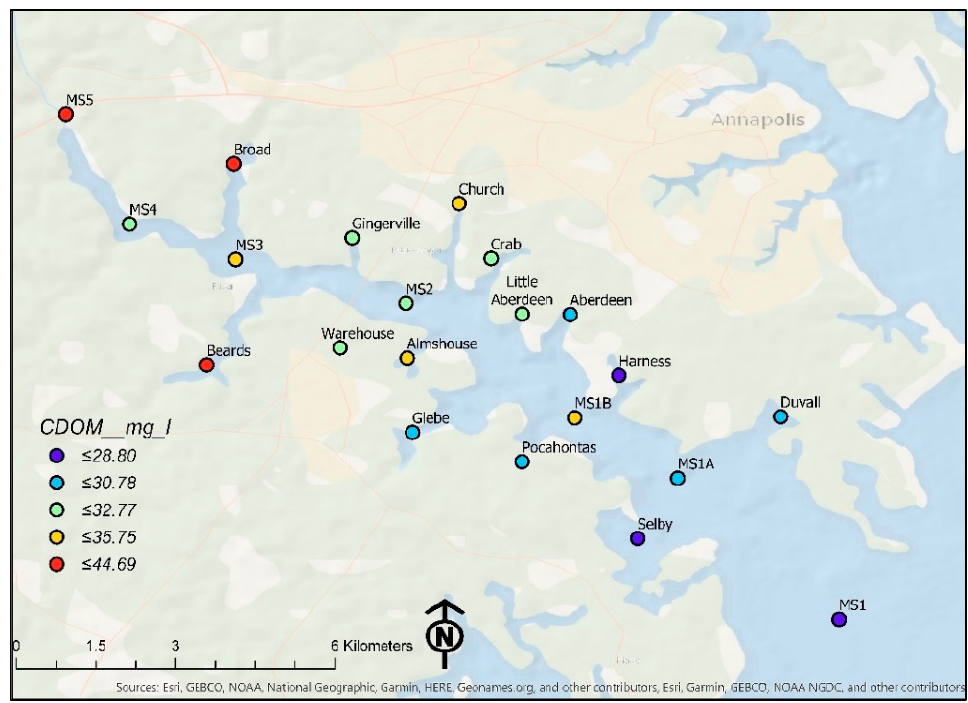
Figure 5. CDOM median concentrations indicate the source of CDOM is in the headwaters of the triblets/estuary and not sourced from the Chesapeake Bay.